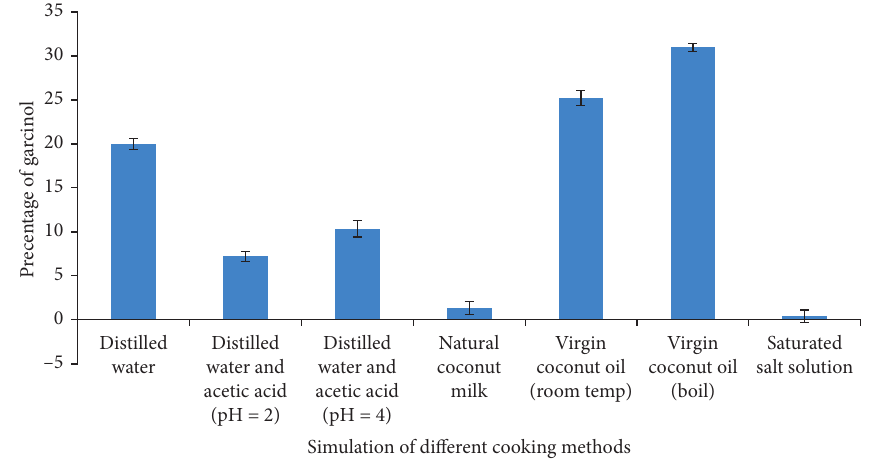
Figure 3: Percentage of garcinol content in different cooking samples. Each data point is the triplicate